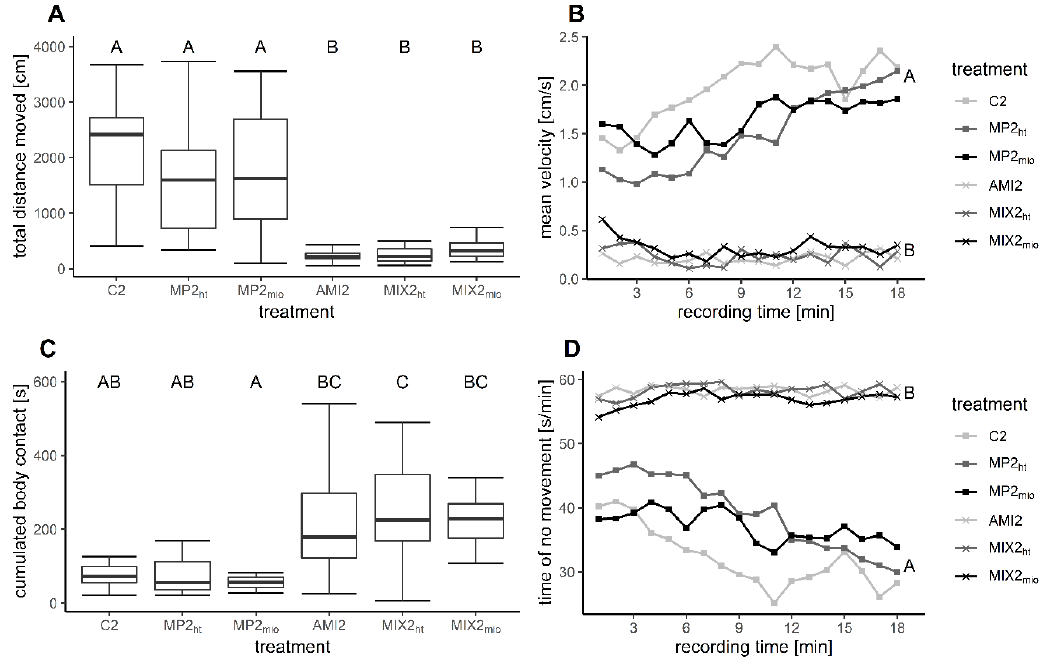
Figure 6. Behavior of brown trout during video tracking (n = 15 in each group). ( a ): Total distance moved in 18 min. ( b ): Mean velocity. ( c ): Total time individuals had body contact. ( d ): Time of no movement over recording time. ( a ) and ( c ): The box plots display the median, the 25th and 75th percentiles as well as minimum and maximum values (whiskers); the dots indicate outliers. Different letters indicate significant differences.